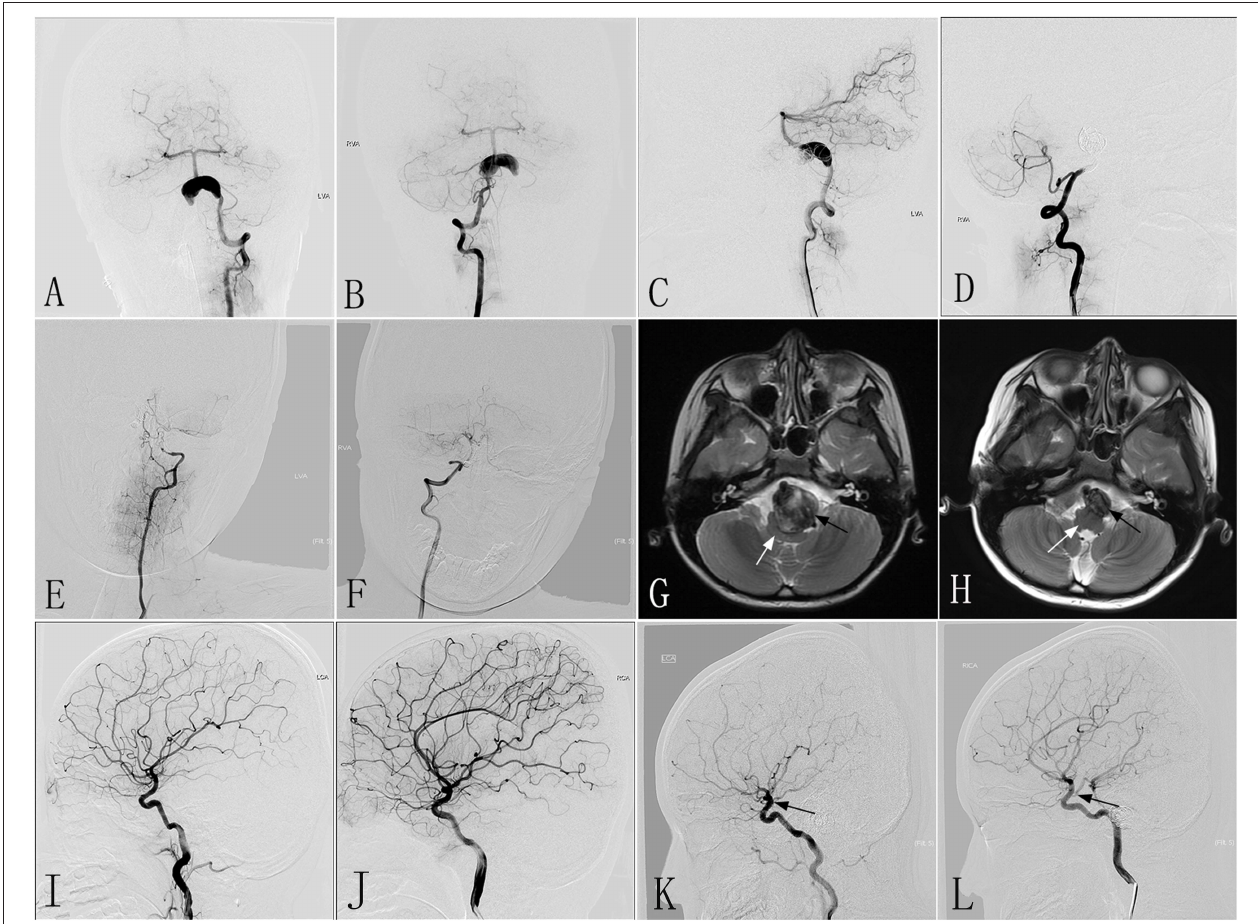
FIGURE 3 | Images from an 8- to 10-year-old patient with a giant dissecting aneurysm located in the VBJ (case 3). (A,B) Preoperative anteroposterior angiograms of the LVA (A) and RVA (B) showing a giant dissecting aneurysm in the VBJ. (C,D) Immediately postoperative lateral angiograms showing the successful reconstruction of the LVA (C) and the complete occlusion of the RVA by coiling (D) . (E,F) Six-month post-treatment angiograms confirming the complete occlusion of the LVA (E) and the RVA (F) . (G,H) Six-month post-treatment MRI (H) compared with MRI performed 1 day post-treatment (G) demonstrating the reduction in the aneurysm size (black arrow) and increased space around the brainstem (white arrow). (I,J) Preoperative angiograms of the left and right ICA demonstrating weak dual-sided PCoAs. (K,L) Six-month post-treatment angiograms of the left and right ICA confirming robust dual-sided PCoAs (black arrow) providing sufficient blood for posterior circulation. VBJ, vertebrobasilar junction; LVA, left vertebral artery; RVA, right vertebral artery; ICA, internal carotid artery; PCoAs, posterior communicating